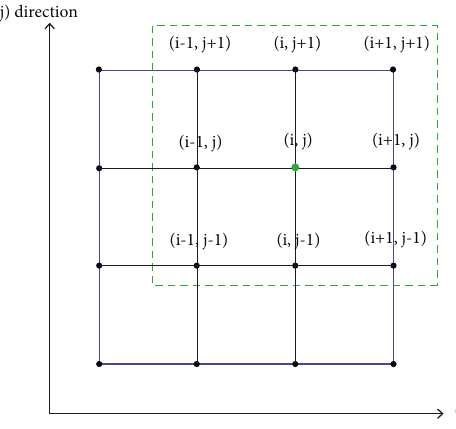
Figure 3: 4 × 4 grid with a 9-point